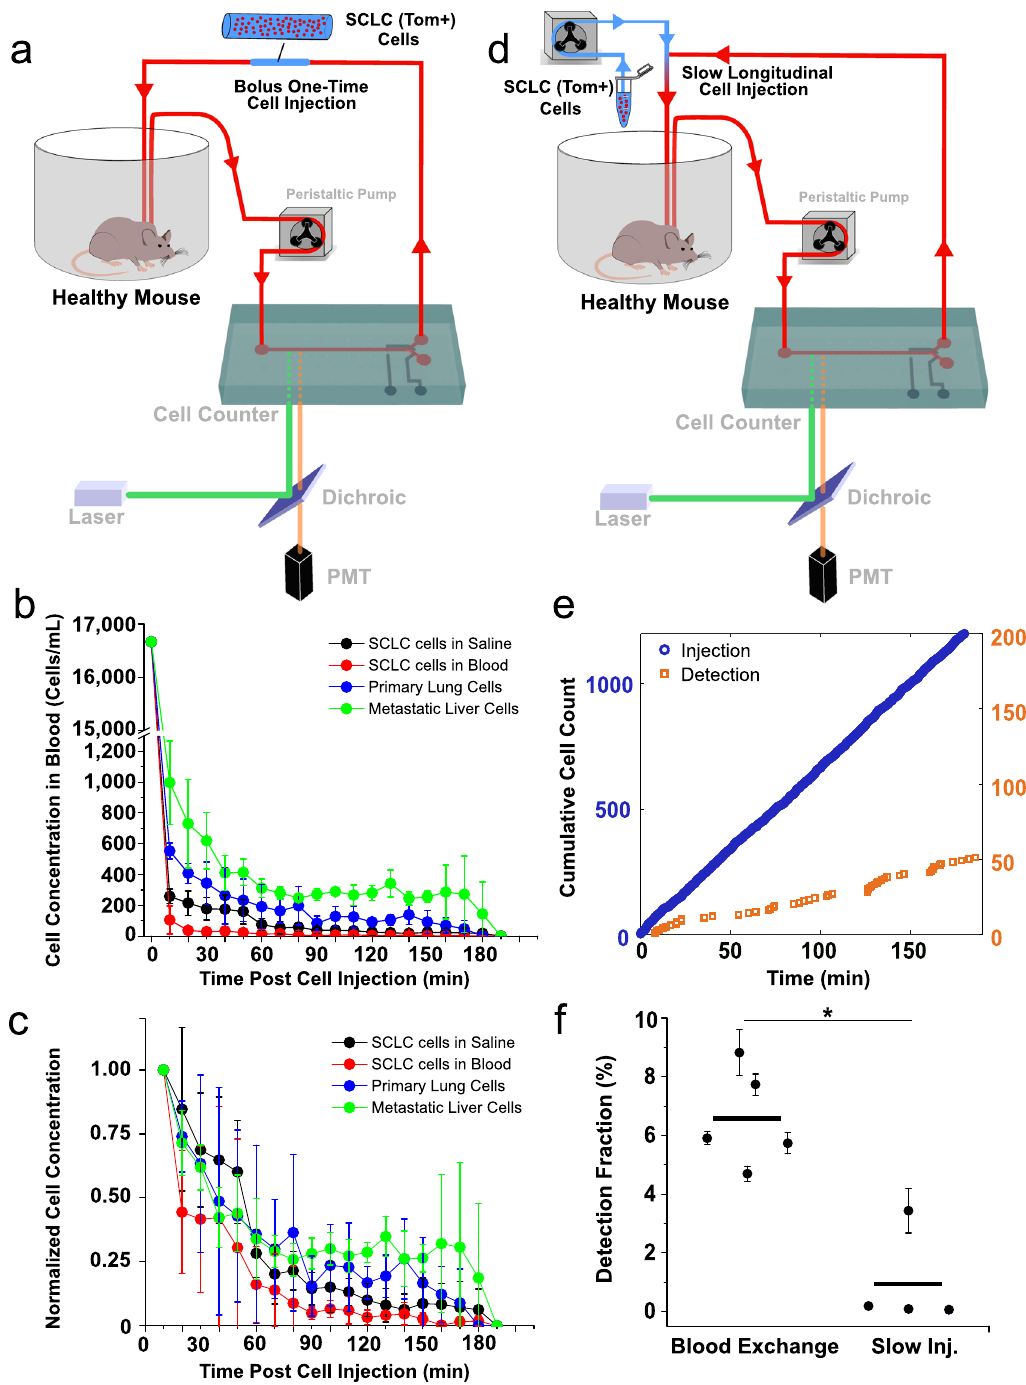
Fig. 3 Comparison of CTC circulatory kinetics to SCLC cell line. a Schematic demonstrating the bolus cell-injection experiment con fi guration. A short segment of tubing fi lled with approximately 40 µ L of blood or saline containing 25,000 cells of either SCLC cell line, dissociated primary tumor cells, or dissociated liver metastatic tumor cells is added to the blood return line at the beginning of the experiment for a direct injection of its contents into the circulation within approximately 1 min. Clearance kinetics plots representing the real-time concentration ( b ) and the normalized concentration to the initial ( fi rst 10 min) detected concentration ( c ). For each group, n = 3 biologically independent experiments. Data are presented as mean ± standard deviation. d Schematic demonstrating the slow cell-line injection experiment con fi guration. A second peristaltic pump is used to slowly infuse cell-containing saline into the circulation at a fl ow rate of 2 − 3 µ L/min, with total injected cells mimicking that of the CTC blood exchange experiments. e Cumulative injection (blue) and detection (orange) cell counts over time. f Detection fraction plot representing the average fraction of total detected cells to the total injected cells in the last 30, 45, and 60 min of fi ve blood-exchange experiments and four slow-injection experiments. N = 5 biologically independent blood exchange experiments and n = 4 biologically independent slow injection experiments. All values are represented as mean ± standard deviation. (* p < 0.05 ( p = 0.016), two-sided Mann − Whitney − Wilcoxon non-parametric